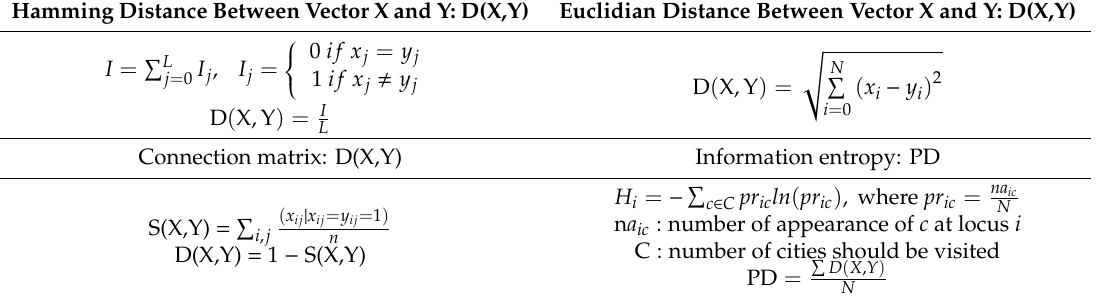
Table 5. Measuring the